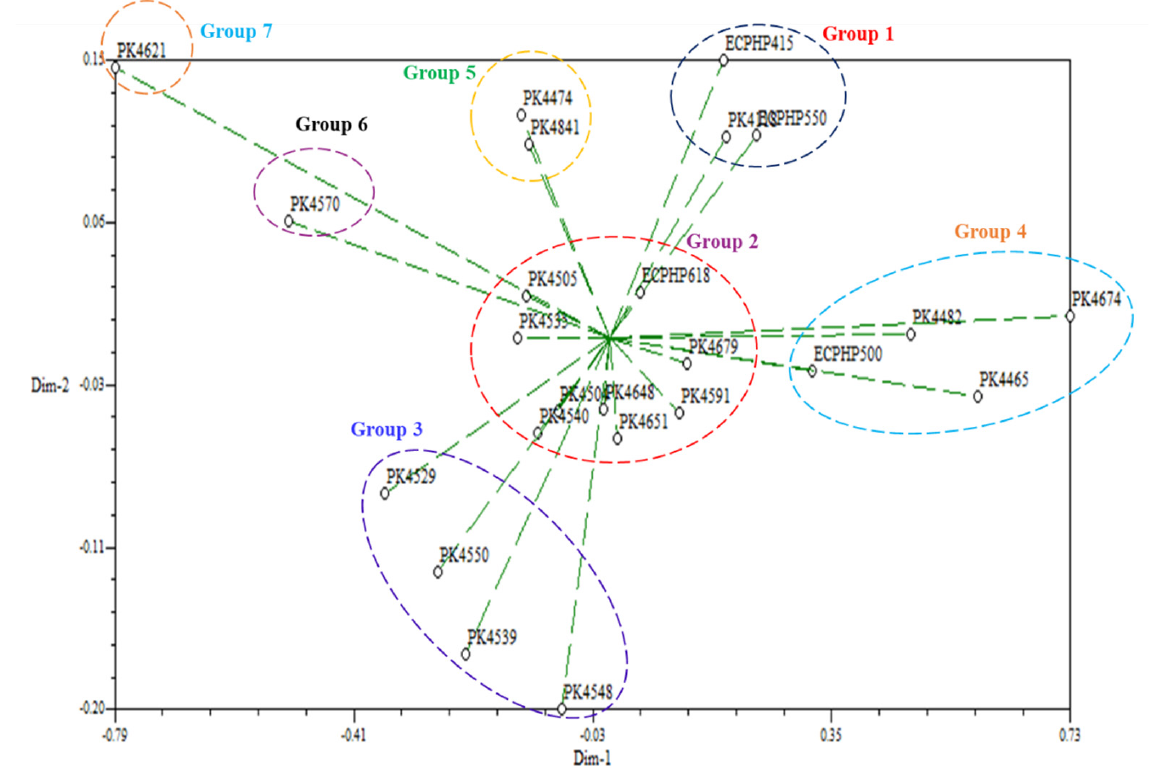
Figure 8. Principal integral component analysis showing relationships among 24 biparental progenies: (ECPHP) Elaeis guineensis crossing program Hulu Paka, (PK) Porim Kluang.